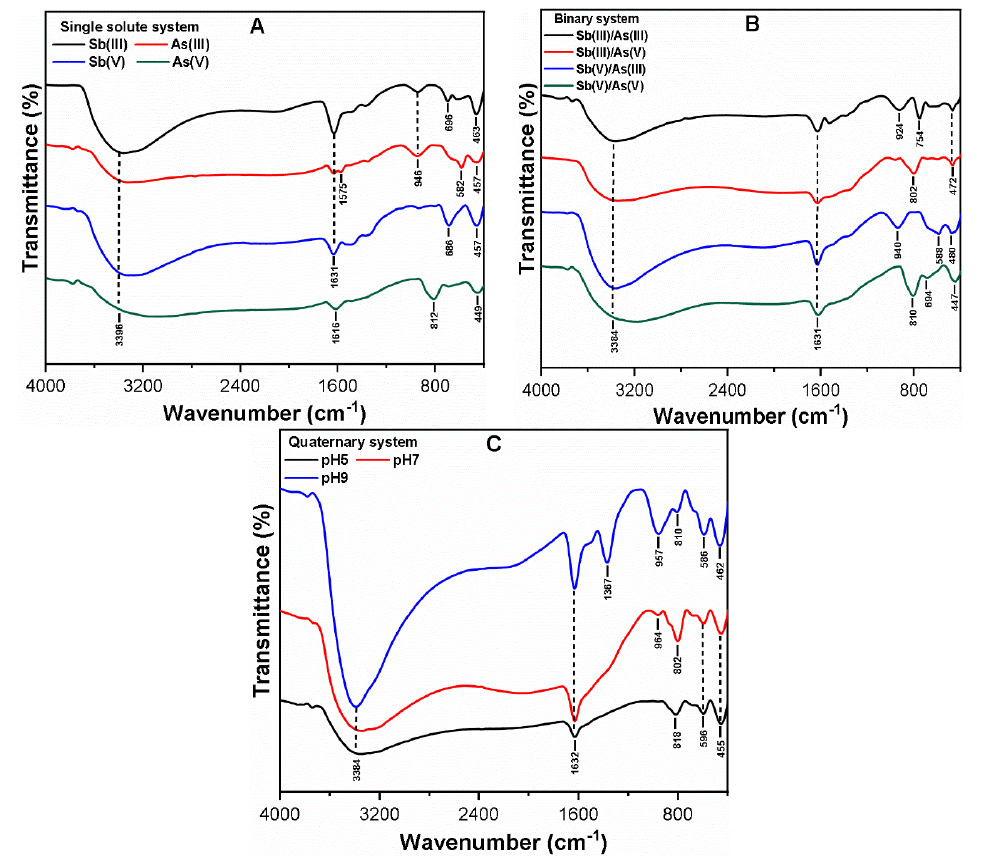
Figure 7. FT-IR spectra analysis of FC contaminants flocs showing ( A ) Single solute; ( B ) binary; and ( C ) quaternary system, after coagulation with 0.1 mM FC dose.